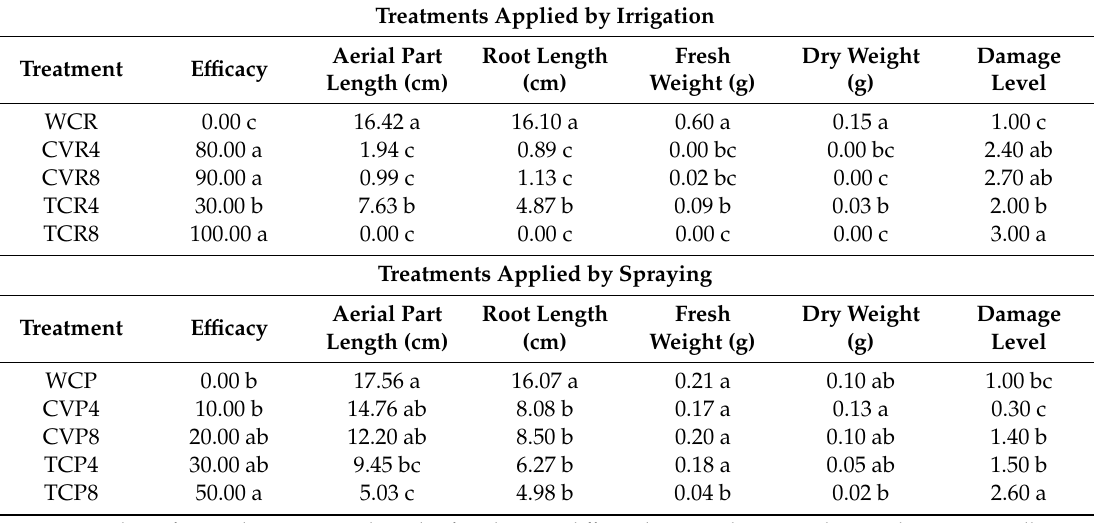
Table 12. E ffi cacy, e ff ects on several plant traits (aerial part, root and total length, fresh and dry weight), and damage level of TC4 EO (TC) and carvacrol (CV), applied at 4 and 8 µ L / mL, by irrigation (CVR4, CVR8; TCR4, TCR8) and spraying (CVP4, CVP8; TCP4, TCP8) on Avena fatua (WCR: irrigated water control; WCP: sprayed water control).